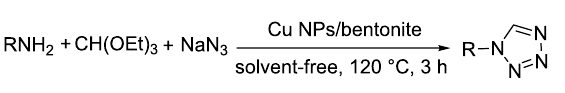
The surface area measurements were performed on Cu NPs/ bentonite. Figure 7 shows the N 2 adsorption–desorption isotherm and BJH pore size distribution plot of Cu NPs/ bentonite. The results indicate that the surface area, total pore volume and average pore diameter were 19.1 m 2 /g, 0.071 cm 3 /g and 14.79 nm, respectively. For similar Iranian bentonite [34], the surface area, total pore volume and average pore diameter were 31.8 m 2 /g, 0.093 cm 3 /g and 11.7 nm, respectively. The surface area and total pore volume of Cu NPs/bentonite decreased compared to the natural bentonite, whereas its pore size